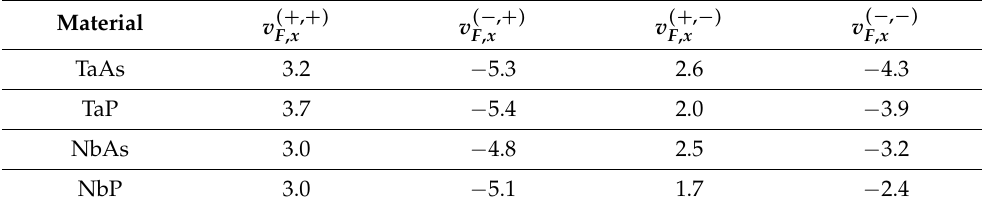
Table 2. Values of the Fermi velocity v ( λ , ξ ) in units of 10 5 m/s, as reported in Ref. [26]. Notice that, F , x for the valence bands ( λ = − 1), they report the hole velocity.